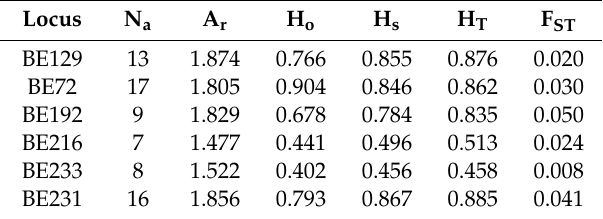
Table 3. Genetic diversity at six microsatellite loci in European